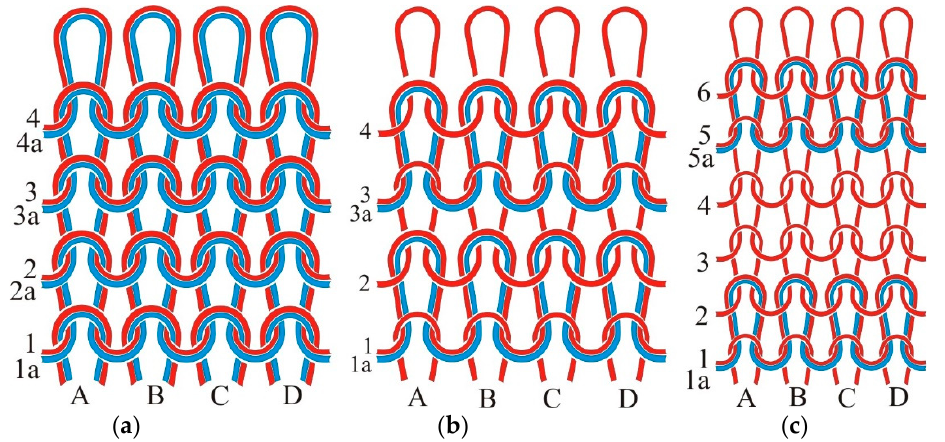
Figure 1. Schematic of plated jersey fabric: ( a ) basic structure; ( b ) partial plating 1 + 1–elastane in every second row of loops; ( c ) partial plating 1 + 3–elastane in every fourth row of loops. 1–6 are basic yarns in course; 1a–4a are plating yarns in course; A–D are wales.